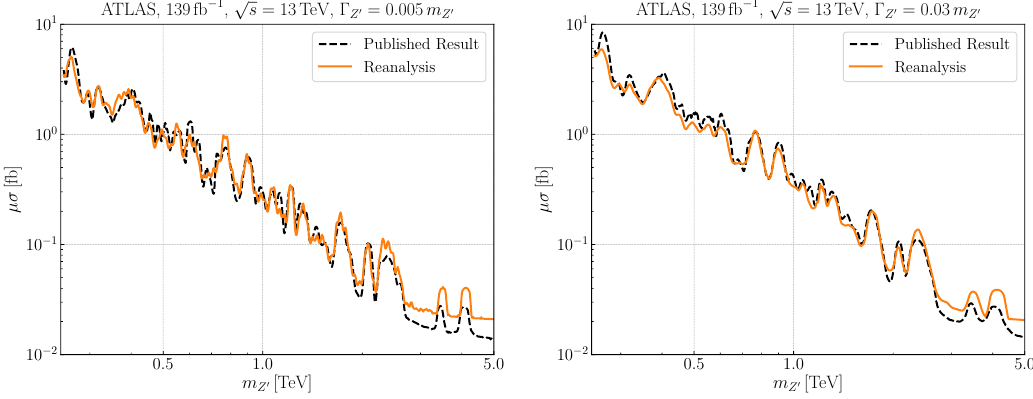
Figure 3 . 95 % con(cid:12)dence limits on signal strength (cid:22) times predicted signal cross section (cid:27) for a Z 0 decaying into e + e (cid:0) or (cid:22) + (cid:22) (cid:0) at ATLAS with (cid:0) Z (right). The axial couplings are set to zero and interference terms are neglected. The experimental bounds are taken from ref.